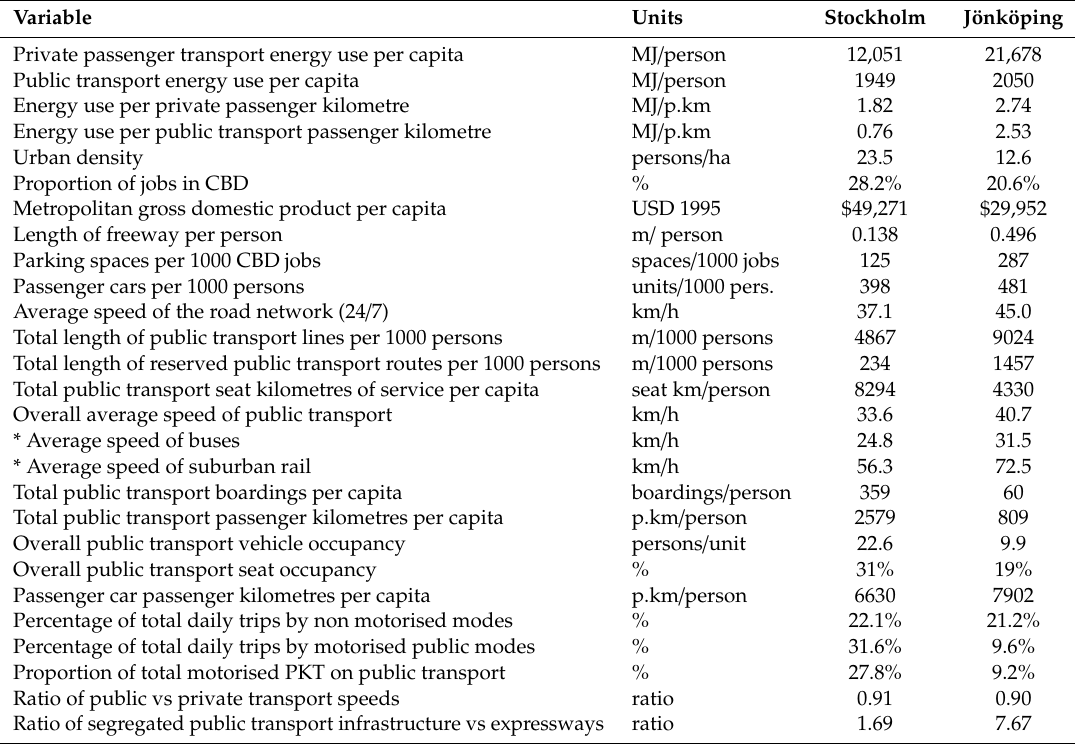
Table 5. Key di ff erences between Stockholm and Jönköping with low compared to high per capita energy use in private passenger